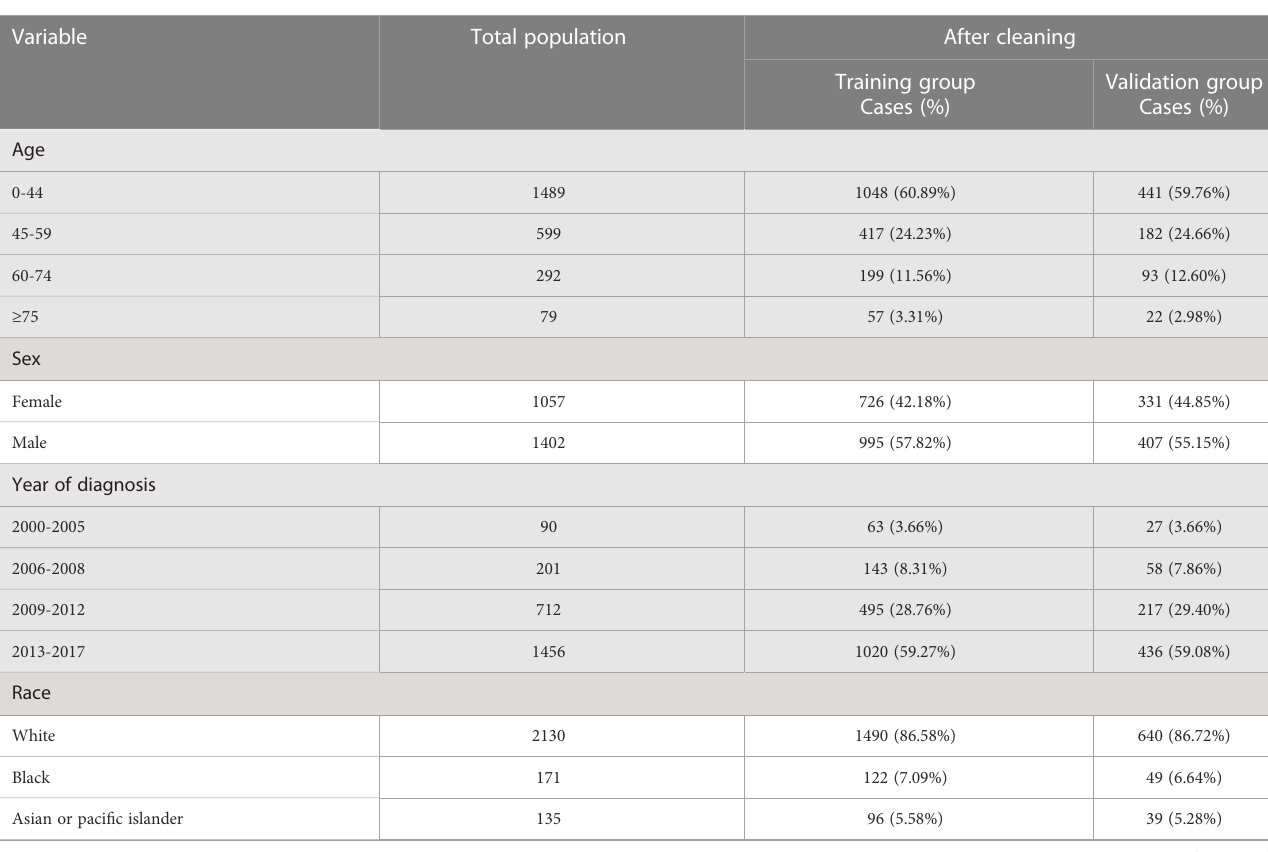
TABLE 1 The clinical characteristics of the enrolled patients. Variable Total population After cleaning